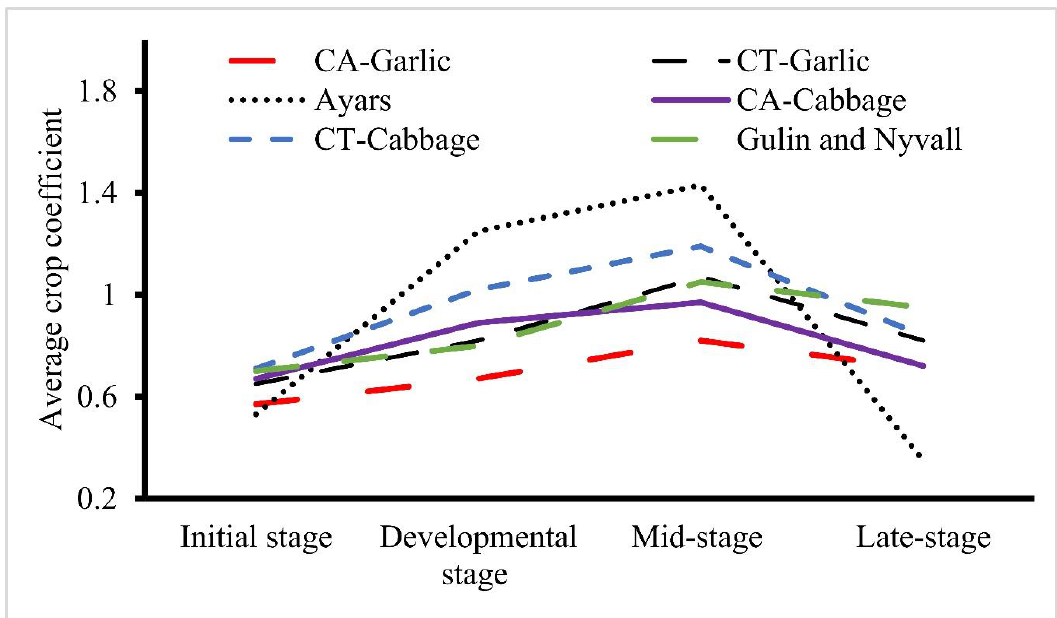
Figure 8. Crop coefficient values of garlic compared with Ayars [64] and cabbage compared with Figure 8. Crop coe ffi cient values of garlic compared with Ayars [64] and cabbage compared with Gulik Gulik and Nyvall [65] for CA management and CT practice. and Nyvall [65] for CA management and CT